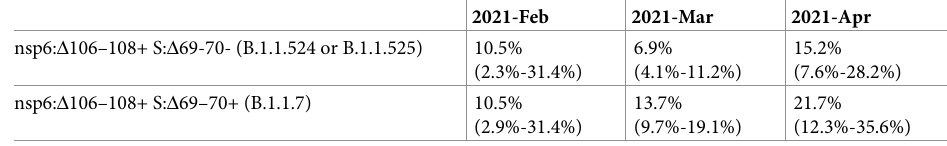
Table 1. Frequencies of (B.1.1.524 or B.1.1.525) and B.1.1.7 estimated from PCR